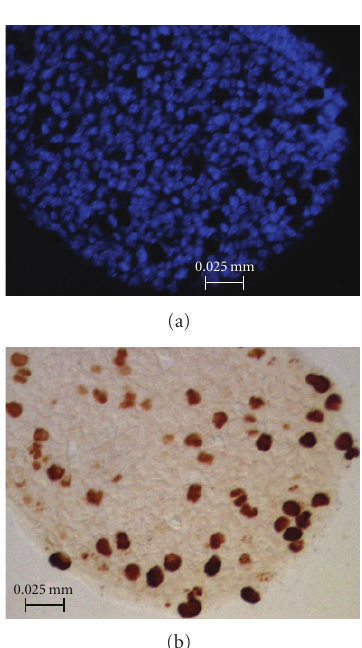
Figure 7: Sample tissue slices used in the experiments. (a) DAPI- stained nuclei shown under a UV light source. (b) DAB-stained cells shown under a bright-field light source.